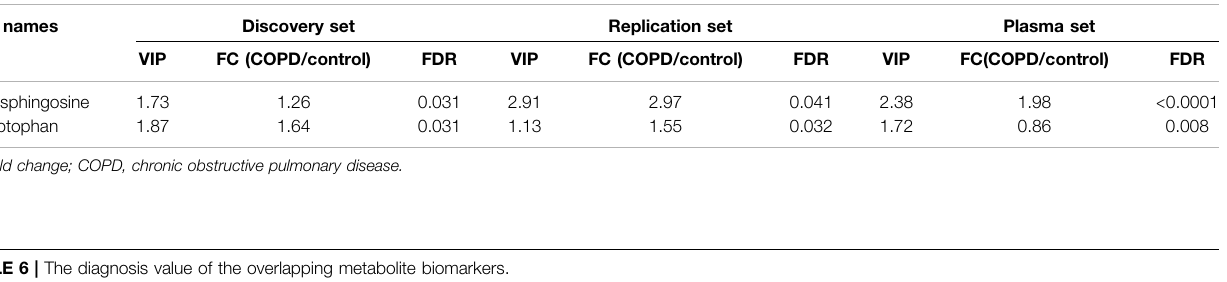
TABLE 5 | Overlapping metabolites in lung between Discovery set and replication set.